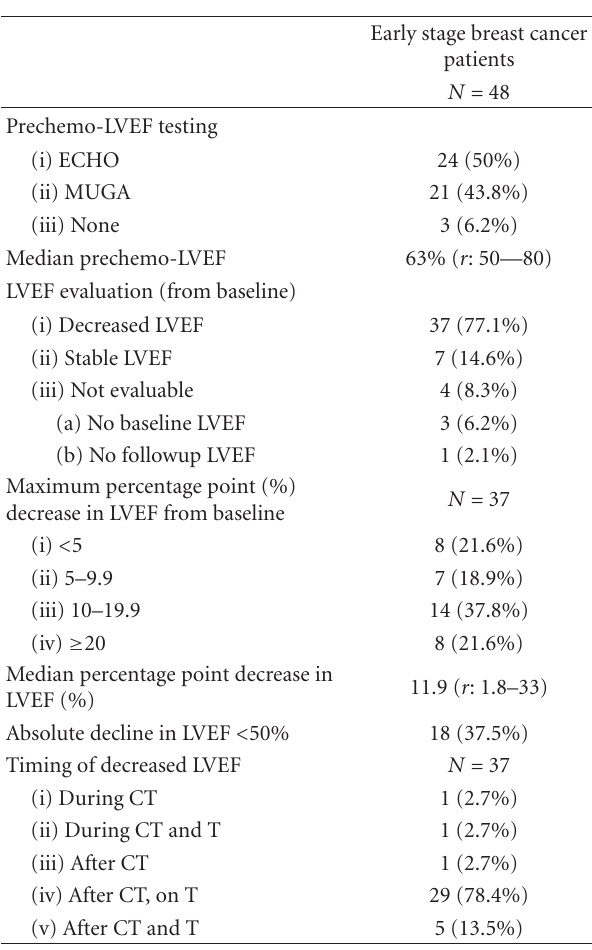
Table 3: Cardiac measures.